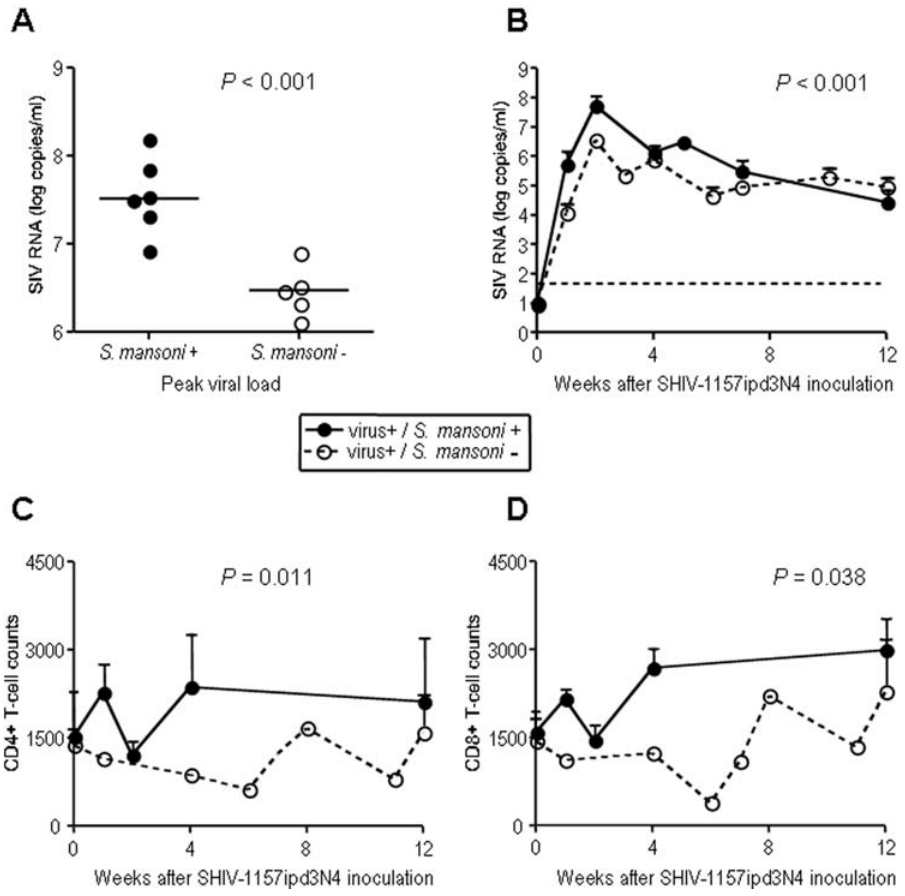
Figure 2. Virology and T cell subsets of schistosome infected and control animals following exposure to SHIV-C. (A) Peak vRNA loads (week 2 post-inoculation) and (B) longitudinal vRNA loads in coinfected and parasite-free monkeys. (C) CD4 + and (D) CD8 + T cells in coinfected and parasite-free monkeys. Lines in panel (A) represent group medians. For panels (B), (C) and (D), points represent group means and error bars represent standard deviations. Statistical analysis of data in panel A was performed using the Wilcoxon rank-sum test. Data in panels B–D were analyzed using repeated measures analysis and generalized estimating equations to compare the data over time for the two groups.